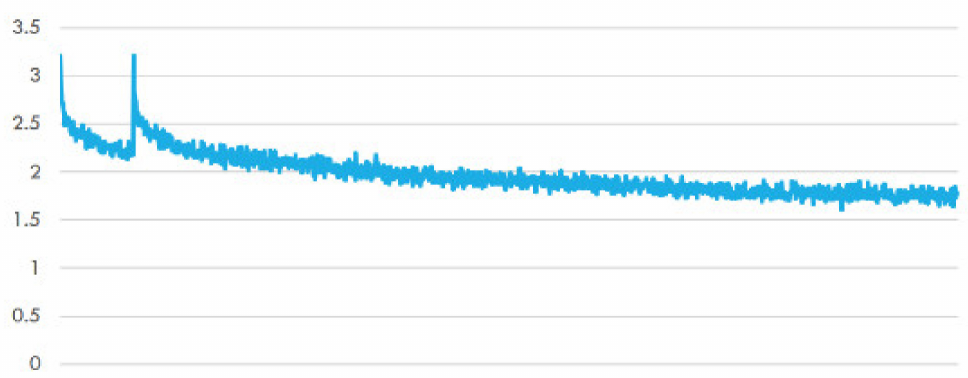
Figure 5. Training loss at every 50 steps of BERT-domain specific fine-tuning.